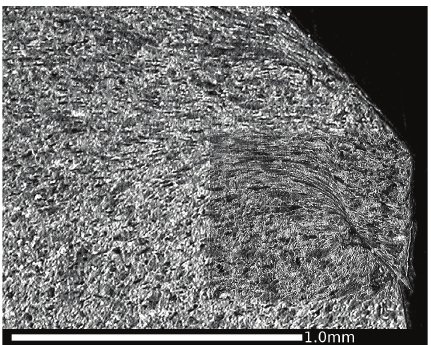
Figure 18: OM image of microstructure on the field side tread chamfer, showing localised plastic flow (Region F2). Together with the lack of microstructuralshearinthemajorityofRegionF,thissuggeststhatmaterial“rollover”onthefieldsideofthiswheelisalocalisedphenomenon and not associated with material flow from other parts of the wheel